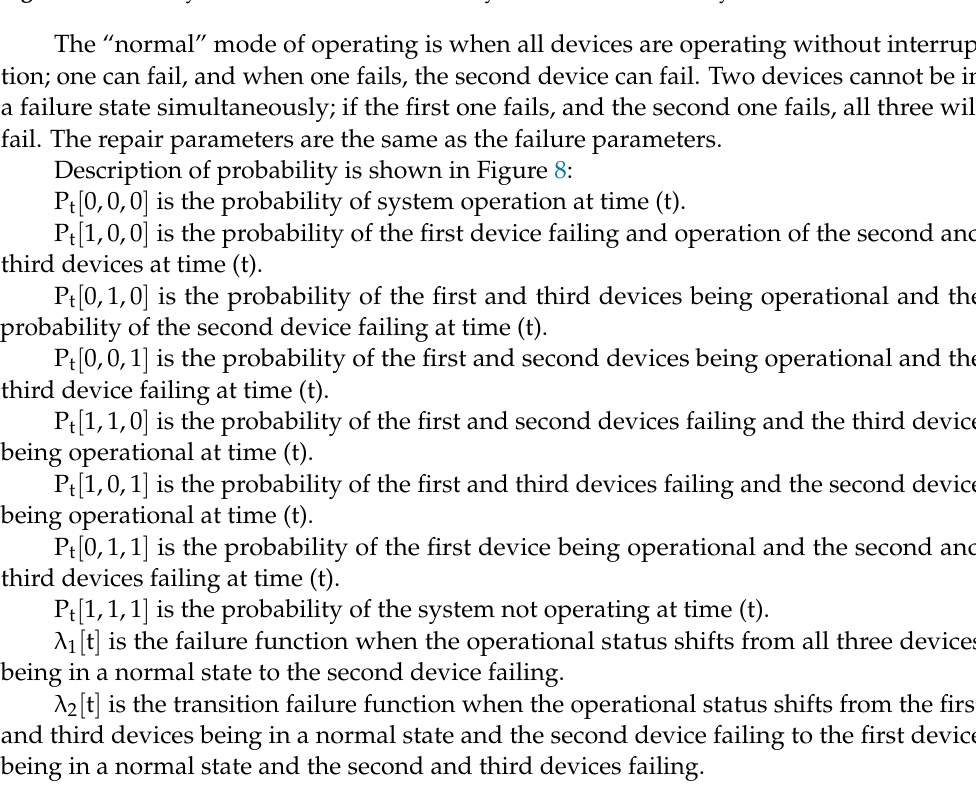
Figure 8. Reliability model of a communication system with dual standby